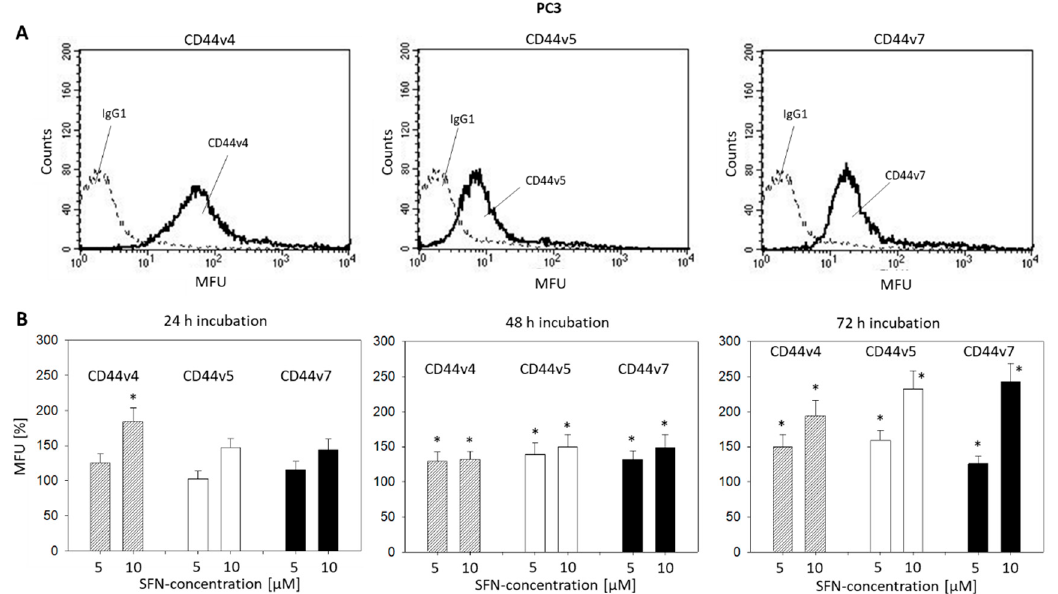
Figure 6. ( A ): CD44 variants v4, v5, and v7 on PC3 cells. MFU = mean fluorescence units. Single representative of three separate experiments. Solid line: specific fluorescence; dashed line: isotype IgG1-APC. ( B ): CD44 variants v4, v5, and v7 following sulforaphane (5 and 10 µM) exposure. Means related to untreated controls (100%). Whiskers indicate SD. * = significant difference to corresponding control, p ≤ 0.05, n = 4.